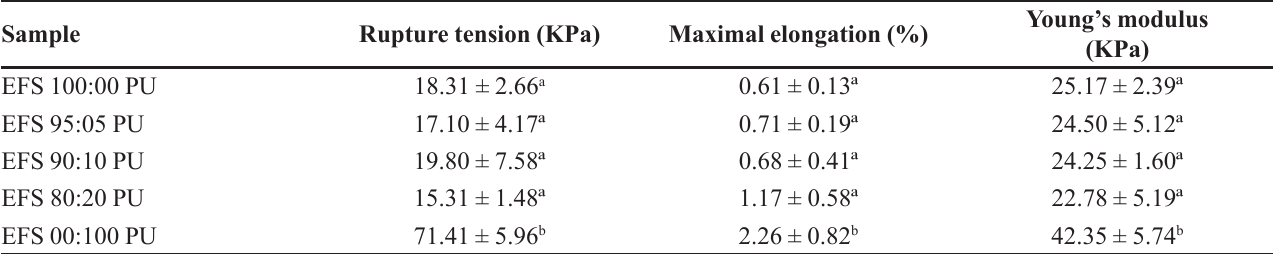
TABLE II - Mechanical properties of EFS:PU films (n=4). Means in a column with different superscripts (a – b) are significantly different ( p <0.05, by Tukey’s